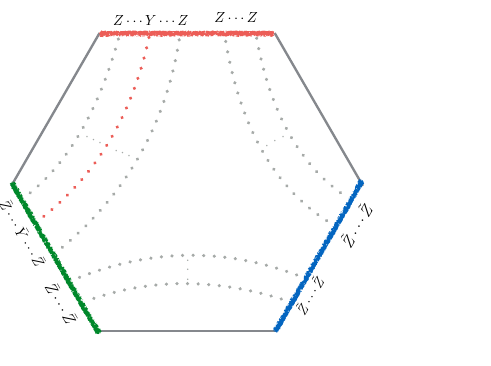
Figure 10 . C direct